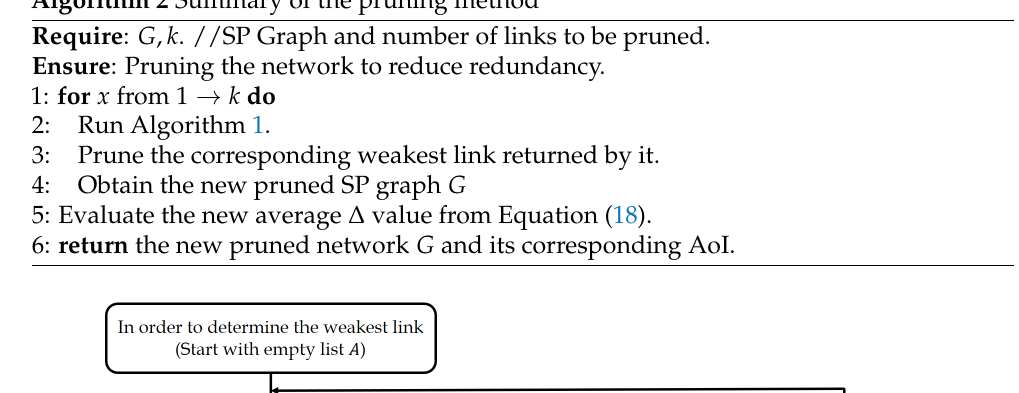
Algorithm 2 Summary of the pruning method